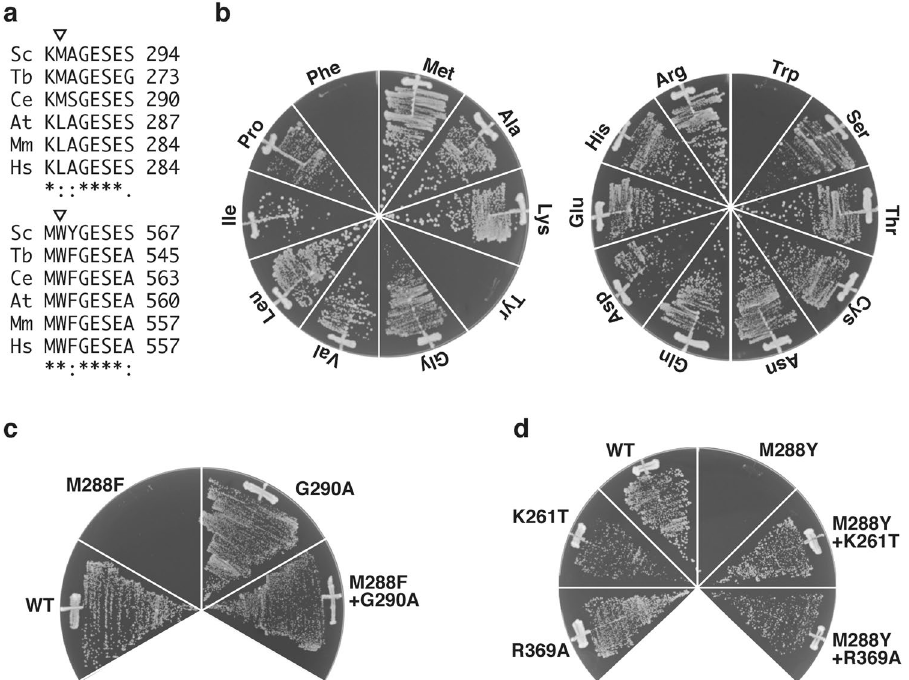
Figure 1. Replacement of the residue 288 of yeast Cdc48 with aromatic amino acids was lethal. ( a ) Eukaryotic Cdc48 homologs were aligned. A whole sequence alignment is shown as Supplementary Fig. S2. The triangles indicate the first positions of the pore loop Φ XG motif sequences of the D1 (upper panel) and the D2 (lower panel) AAA domains. Sc, Saccharomyces cerevisiae ; Tb, Trypanosoma brucei ; Ce, Caenorhabditis elegans ; At, Arabidopsis thaliana ; Mm, Mus musculus ; Hs, Homo sapiens . ( b ) cdc48 ∆ cells carrying pME351, a URA3 -based plasmid expressing Cdc48, were transformed with a HIS3 -based plasmid for the expression of Cdc48 with the indicated amino acid residue at the residue 288. The transformants were grown on media lacking histidine supplemented with 5 ′ -FOA at 30 °C to counterselect against pME351. ( c , d ) Tested were viabilities of cells expressing Cdc48 with the indicated mutations as shown